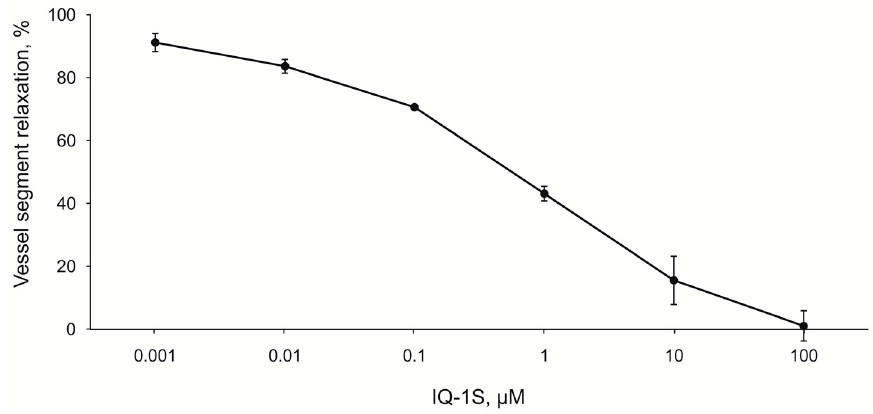
Figure 7. The effects of IQ-1S on the tone of the vascular rings, isolated from the carotid artery and constricted by phenylephrine (1 µ M).